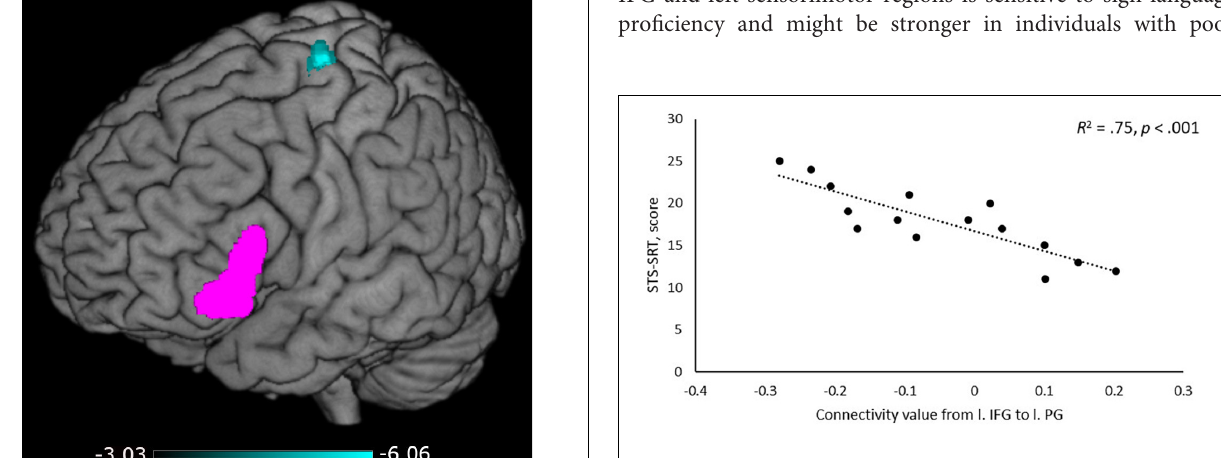
FIGURE 2 | Scatterplot of the association between performance on Swedish Sign Language Sentence Repetition Task (STS-SRT; score on y -axis) and resting-state functional connectivity (connectivity value on x-axis) between the seed in left inferior frontal gyrus (l. IFG) and the peak in left precentral gyrus (l.